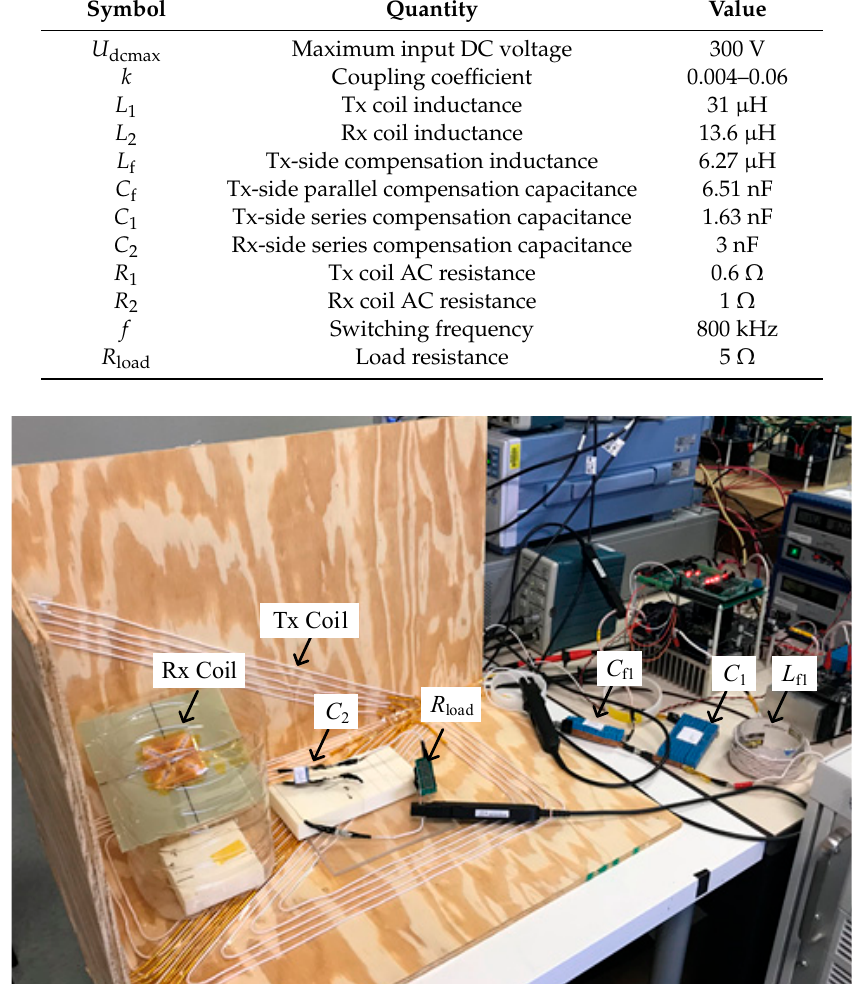
Table 2. Spatial free-positioning wireless charging system specification.